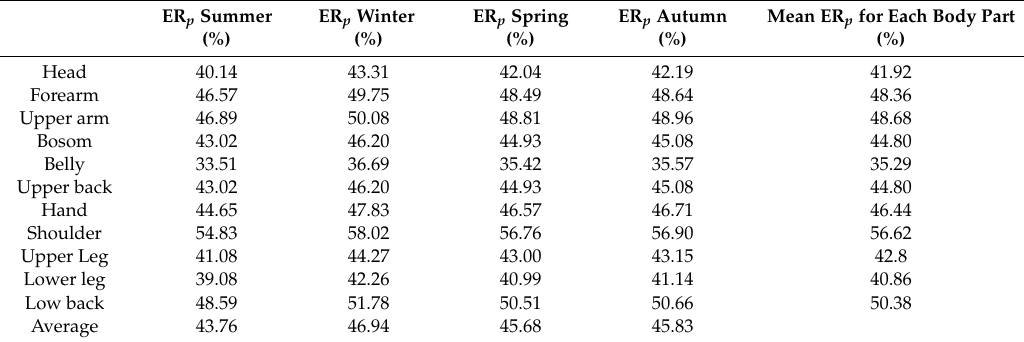
Table 2. Exposure Ration (ER) for 11 body parts in four seasonal days.